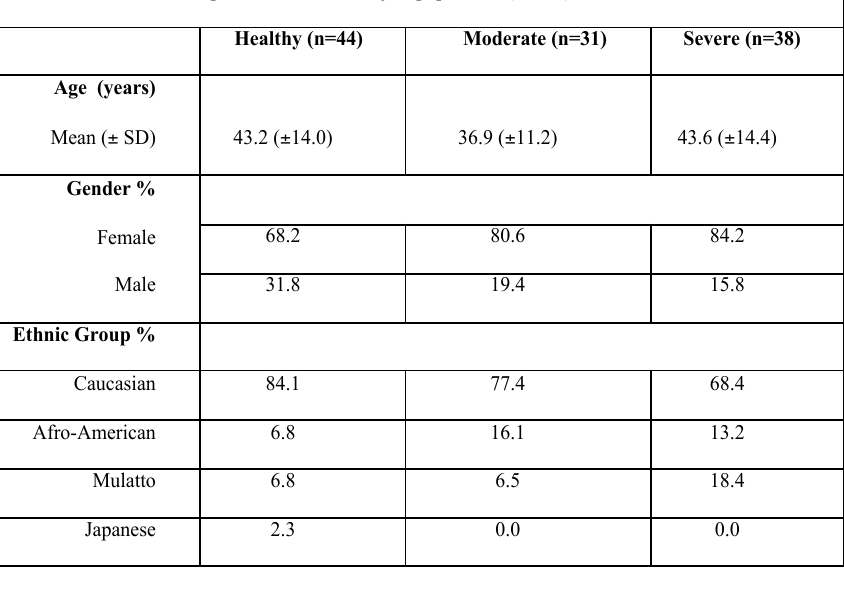
Table 1. Baseline clinical parameters of the subject population